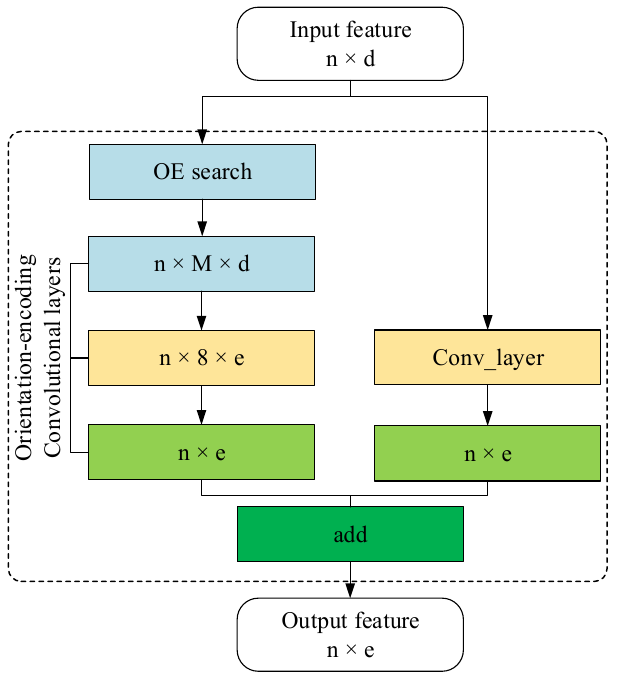
Figure 3. OE convolution module.